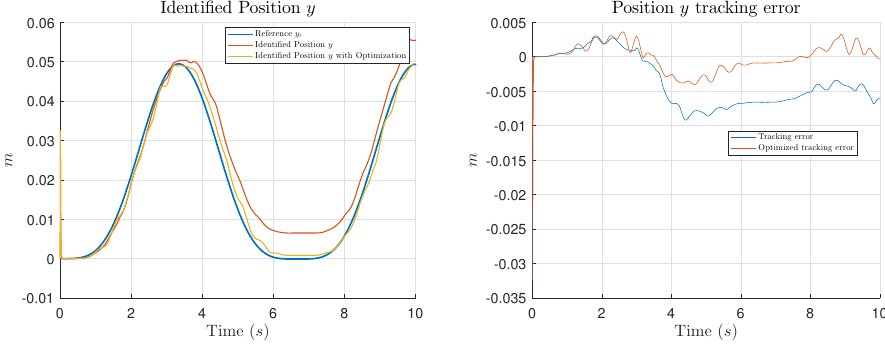
Figure 13. Tracking of y position ( left ) and error comparison ( right ) for the experimental test 2.